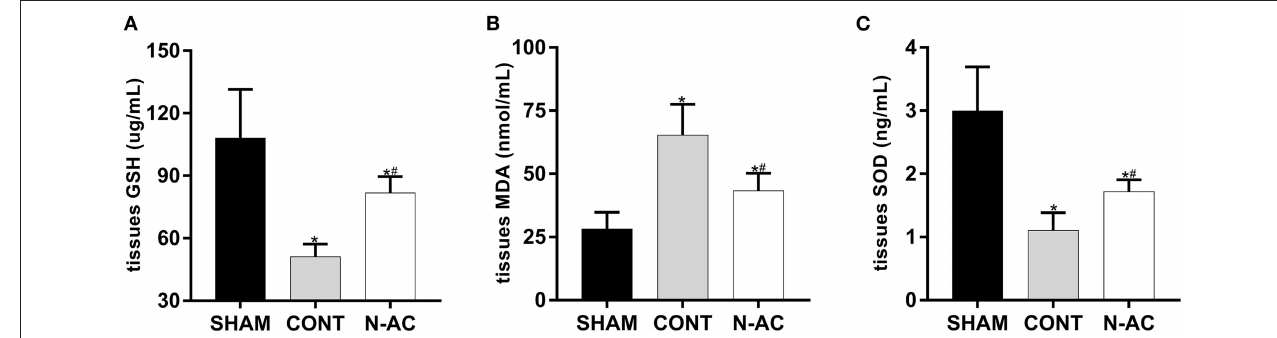
FIGURE 4 | N-AC suppressed renal oxidative stress at 6h after ROSC. (A) The concentration of GSH-PX in the renal tissues. (B) The concentration of MDA in the renal tissues. (C) The concentration of SOD in the renal tissues. SHAM, sham group; CONT, control group; N-AC, N-AC group. Sham group, n = 5; Control group, n = 7; N-AC group, n = 7. Data are expressed as mean ± SD. * P < 0.01, vs. sham group; # P < 0.01, vs. control group.